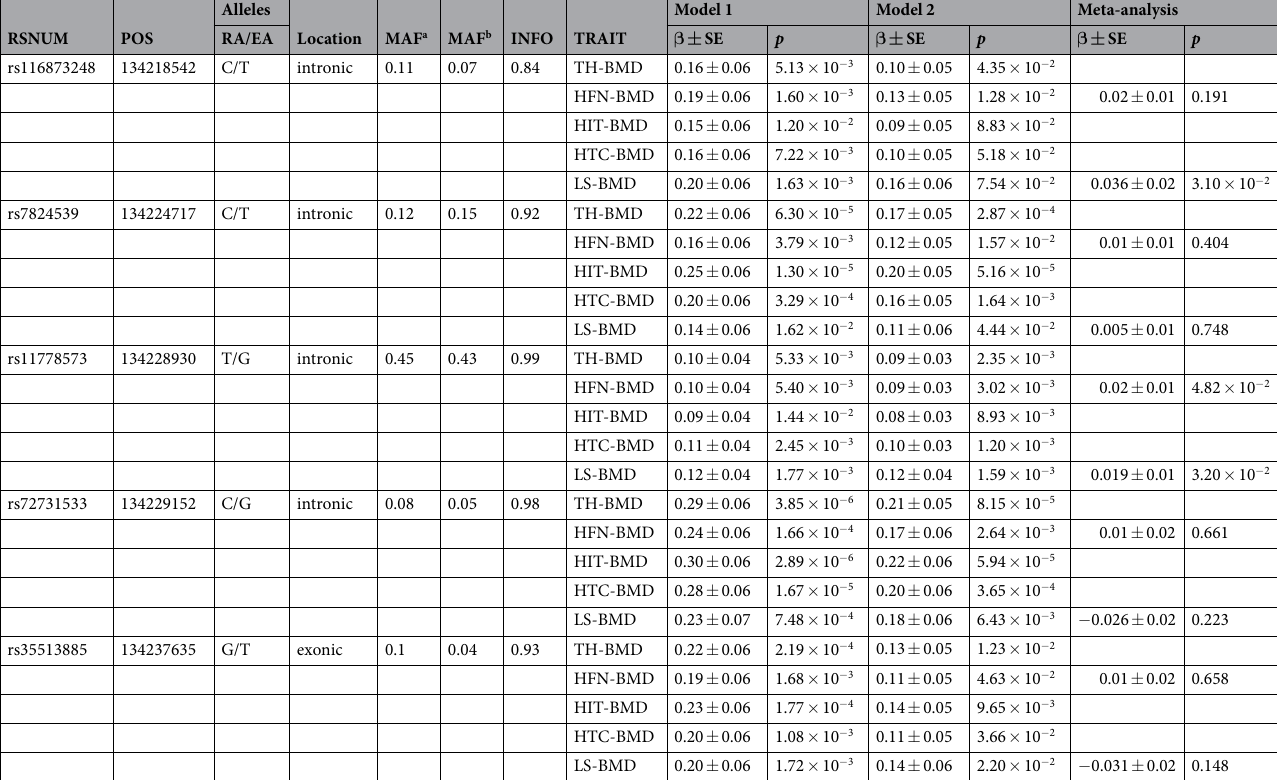
Table 3. Association results of variants surrounding WISP1 gene with BMD traits. TH-BMD: total hip BMD; HIT-BMD: hip intertrochanter BMD; HFN-BMD: hip femoral neck BMD; HTC-BMD: hip trochanter BMD; LS-BMD: lumbar spine BMD; POS: position in the genome based on GRCh37.p13 Annotation Release 105; INFO: imputation quality score; RA: reference allele; EA: effect allele; MAF a : minor allele frequency in the OOA; MAF b : minor allele frequency from meta-analysis of GEFOS.seq project; β : estimates of effect size expressed as adjusted SD per copy of the effect allele; SE: standard error of β ; p : p value; Model 1: covariance including study, sex, age, and family structure; Model 2: covariance including INVNORM, age, sex, age * sex, family structure and BMI; Meta-analysis: 2015 meta-analyses of whole-genome sequencing, whole-exome sequencing, and deep imputation of genotype data devoted by GEnetic Factors for OSteoporosis (GEFOS)